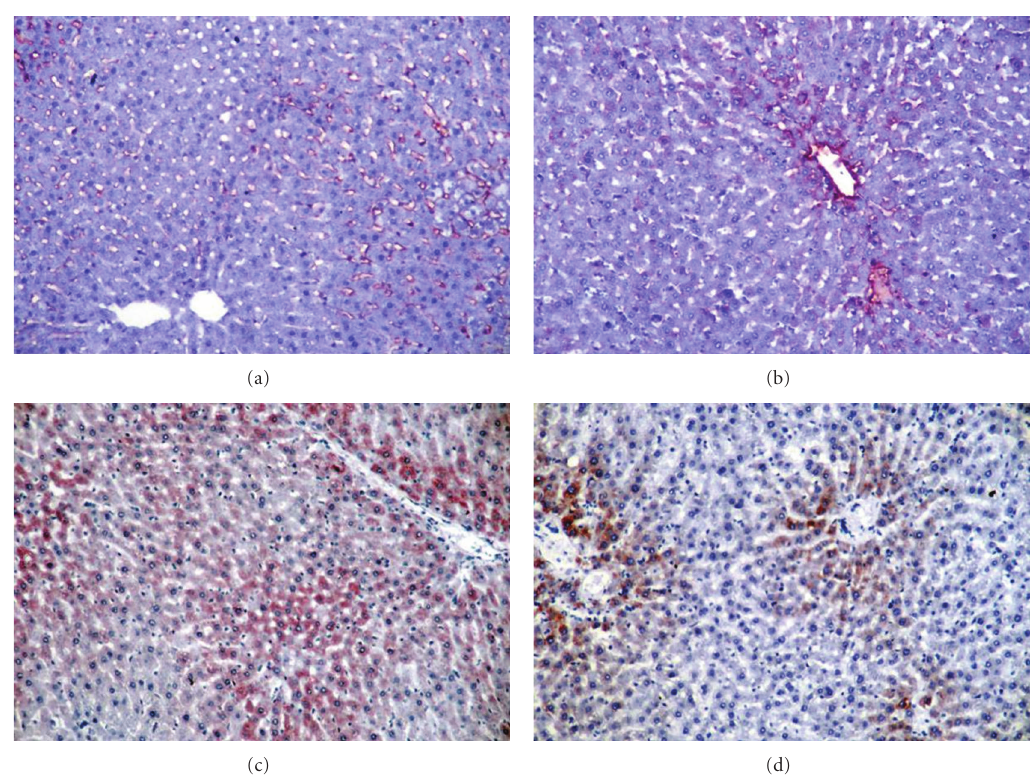
Figure 2: Immunohistochemical analysis. α SMA expression was increased liver sections rat fed on HFD (a), and decreased rat fed on HFD + lycopene (b) (original magnification × 200). CYP 2E1 expression was shown in localization of panlobuler rat fed on HFD (c), and perivenular by rat fed on HFD + lycopene (d) (original magnification ×